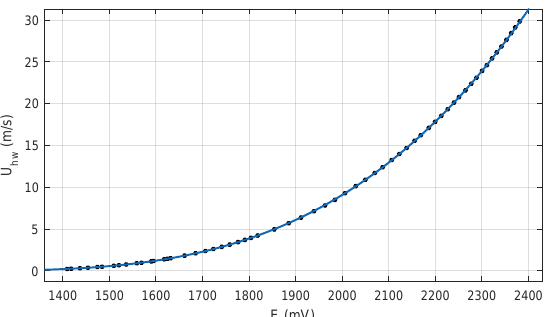
Figure A1. Calibration curve: relation between the applied voltage E hw and the velocity U